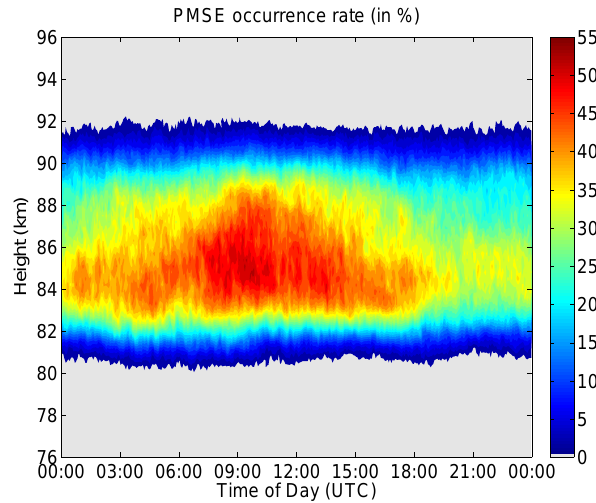
Fig. 4. Seasonal variation of daily mean PMSE thickness averaged over all PMSE events during five summers (upper panel) and during the year 2001 (lower panel).